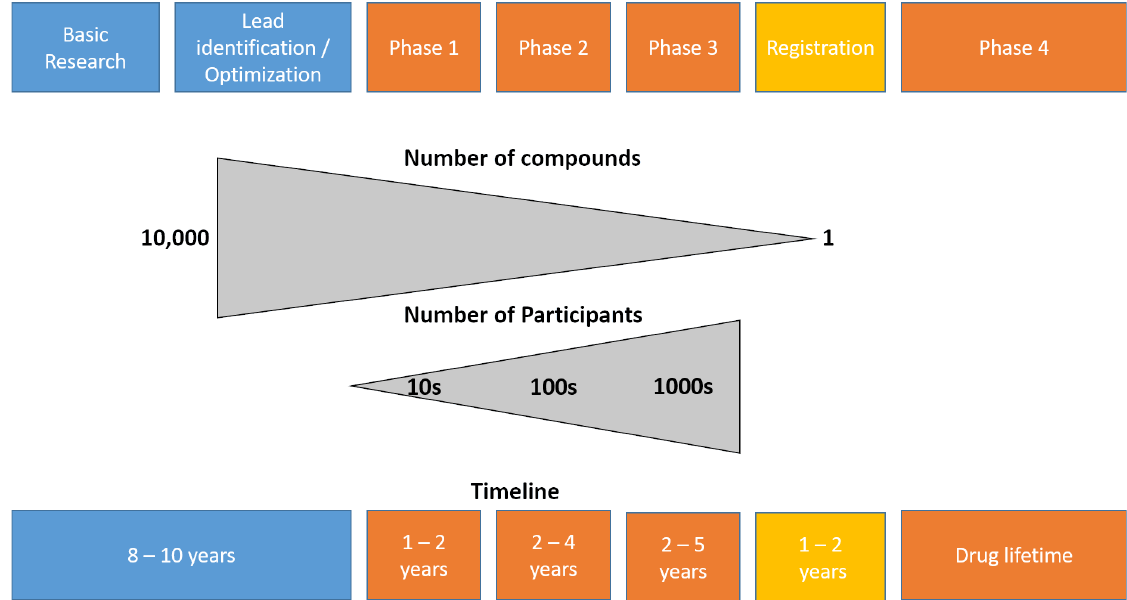
Figure 1. The rocket model, adapted from Verweij et al., 2019 [11]. Note that this model and its numbers relate to the development of new drugs, as no data are available for new interventions in rehabilitation sciences. Blue colors indicate the different steps of the discovery, development and preclinical research, orange represents the clinical development. The different steps of the clinical development are as follows. Phase 1—healthy volunteer study: this is the first time the drugs is tested in people; less than 100 volunteers are usually involved, and the pharmacokinetics, absorption, metabolism, and excretion effects on the body, as well as any adverse effects associated with safe dose ranges, will be determined. Phase 2—small sample size study in patient population: Evaluates placebo or a previously utilized standard of care. The analysis of the ideal dosage strength aids in